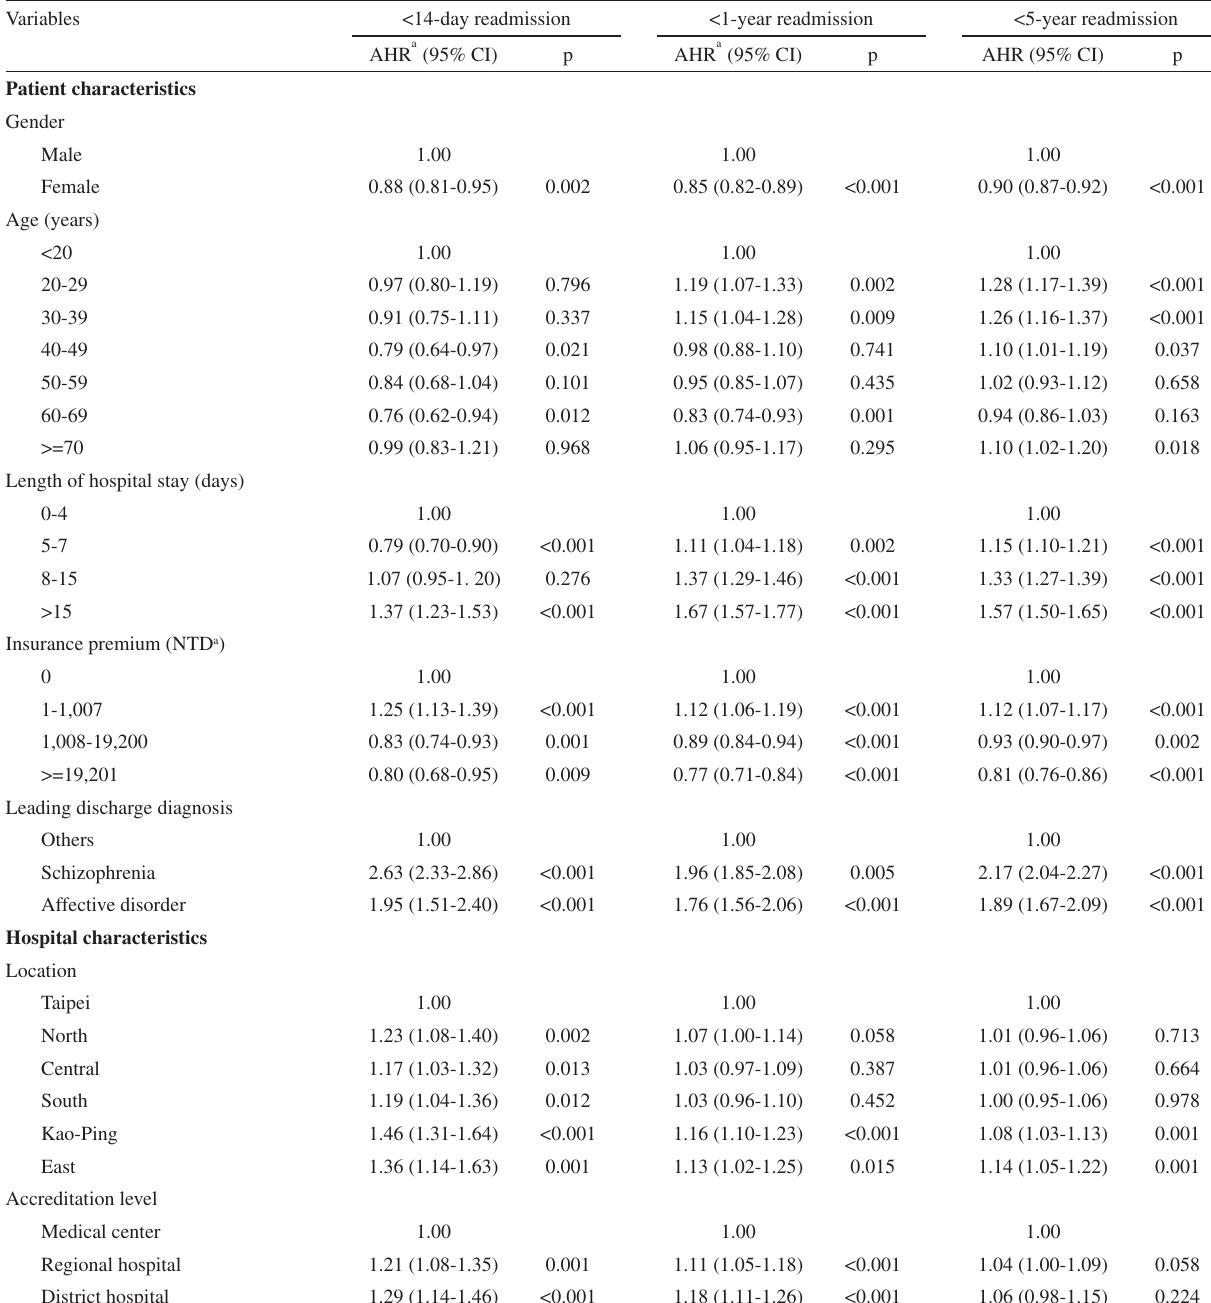
Table 2 - Adjusted hazard ratios of <14-day and <five-year readmission rates in association with various characteristics of patients and hospitals (n =